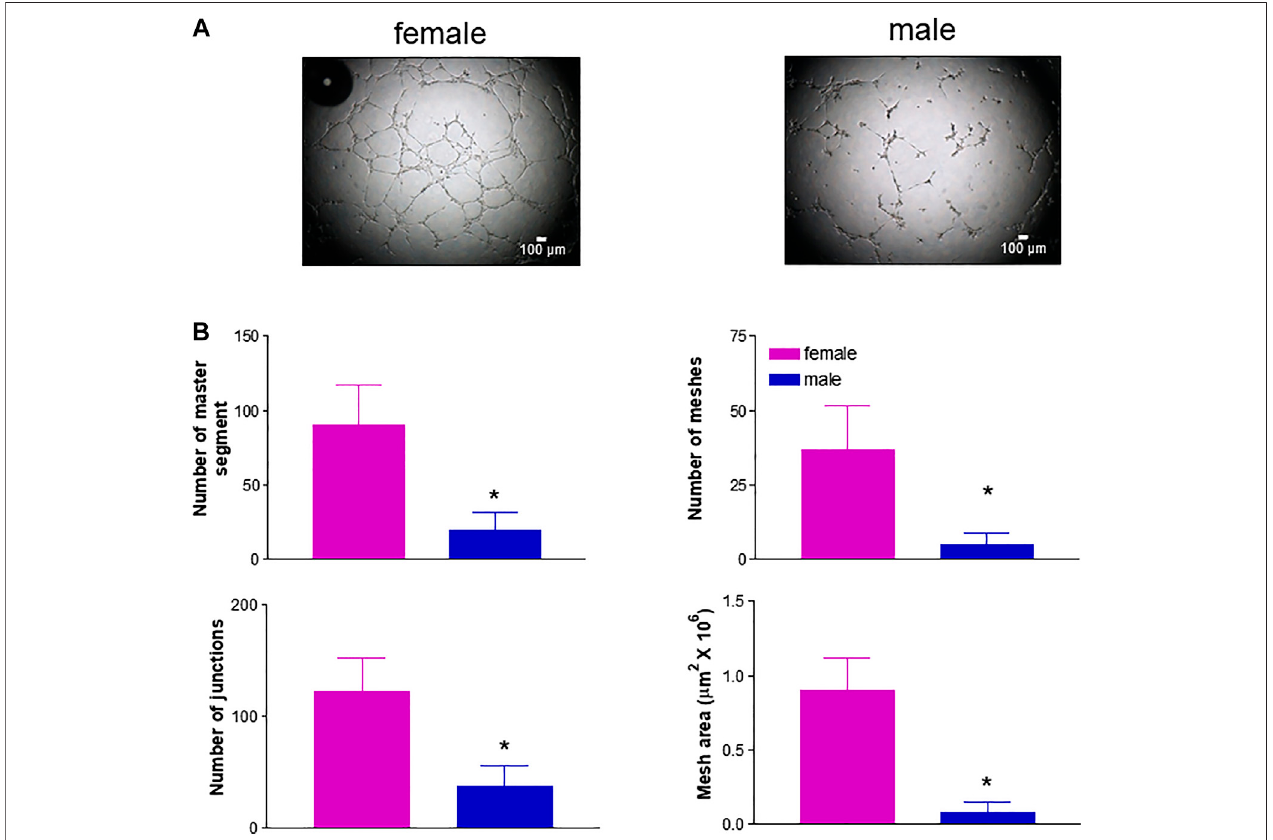
FIGURE5| Effectofdonor ’ ssexoncapillarytube-likeformation.HUVECswereseededonto96-wellplatescoatedwithMatrigelincompleteculturemedium.After incubating for 4 h one micrograph image per well was taken. (A) . Images from a representative experiment; scale bar: 100 μ m. (B) . Analysis of speci fi c parameters of capillary tube formation measured using Angiogenesis Analyser (ImageJ). Each independent experiment ( n (cid:1) 3) was performed using cells from 1 male and 1 female donor. Data are expressed as mean ± SEM. t -test, * p < 0.05.